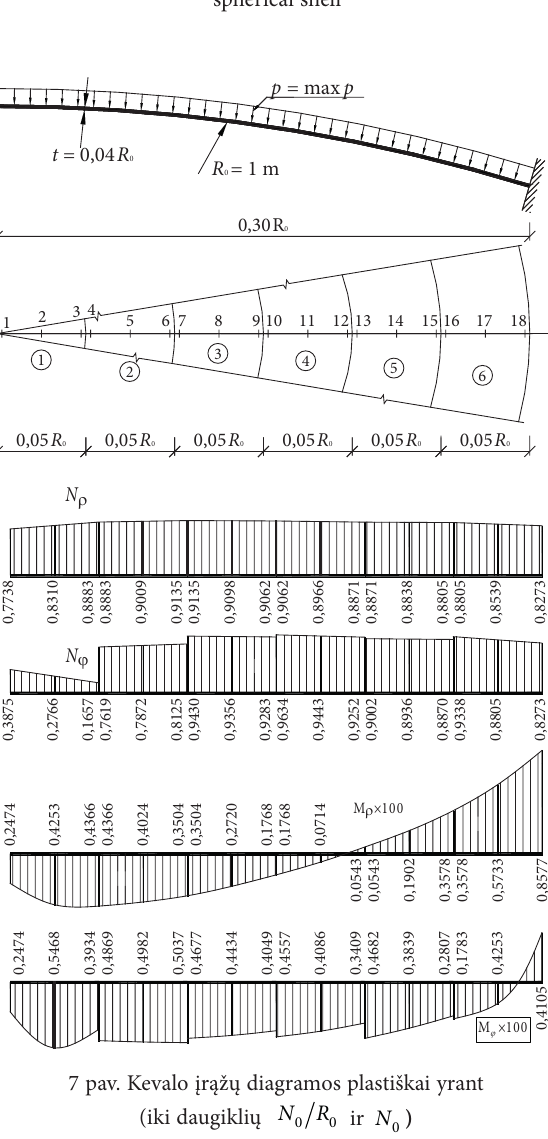
Fig. 7. Displacement and internal forces of shell (up to the factors